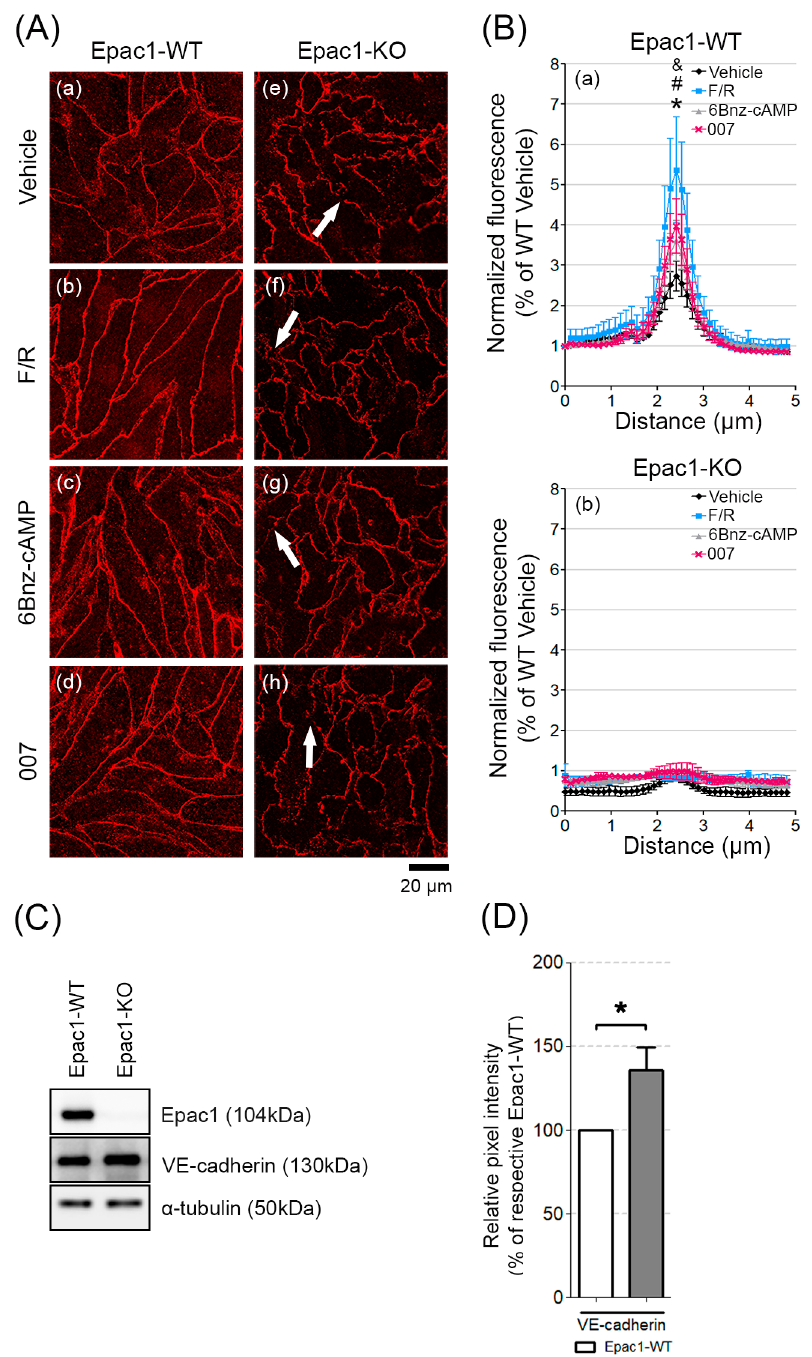
Figure 2. Distribution and basal protein levels of VE-cadherin in confluent MyEnd cell sheets. ( A ) Confluent MyEnd cell monolayers originating from WT (a–d) and Epac1-KO (e–h) mice were treated either with vehicle (DMSO) or with F / R (1 h), 007 (2 h), or 6-Bnz-cAMP (6 h). Arrows indicate VE-cadherin fragmentation among the neighbouring cells. ( B ) Bell-shaped curve representing the distribution of VE-cadherin signal intensity across cell borders. Normalized data collected from WT and Epac1-KO cell lines are presented. N = 4, n = 25; “*” denotes statistical significance for vehicle vs. F / R in WT cell monolayers; “#” for F / R vs. 6Bnz-cAMP; “&” for F / R vs. 007; p ≤ 0.05. ( C ) Western blot analysis of whole cell lysates for Epac1 and VE-cadherin. Equal loading validation was monitored with α -tubulin; N ≥ 10. ( D ) Respective densitometric measurements of the band intensity; N ≥ 10. Full-length blots can be found in the Supplementary Figure S3. Data are presented as mean ±